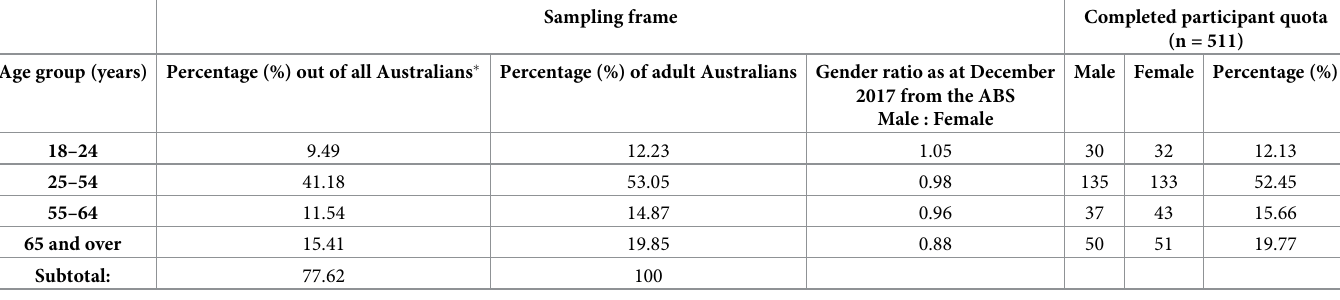
Table 1. Comparison between sampling frame vs. completed participants.